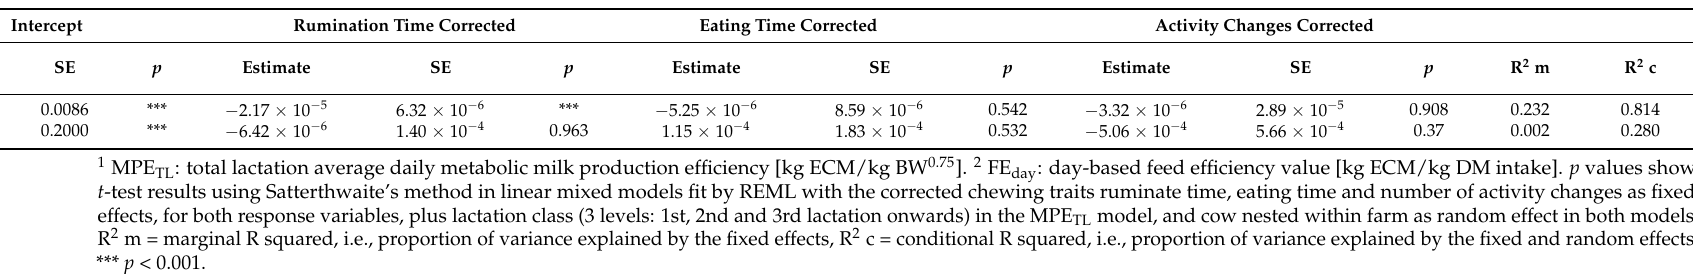
Table 6. Influence of chewing sensor variables corrected for days in milk and feed quality score on metabolic milk production efficiency calculated on the basis of